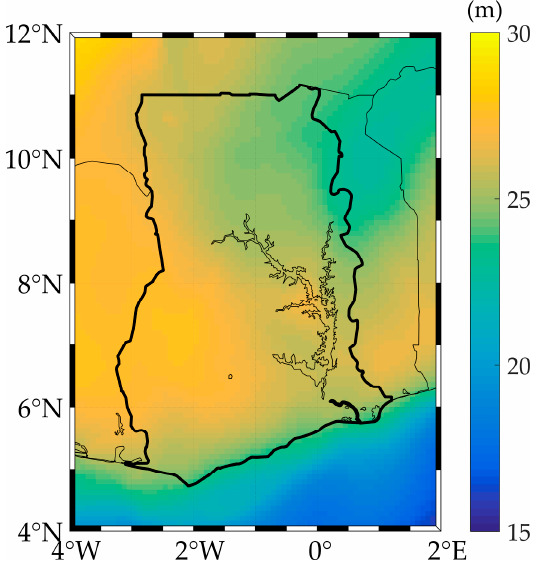
Figure 4. Gravimetric geoid model computed using EGM2008 up to degree and order 222.